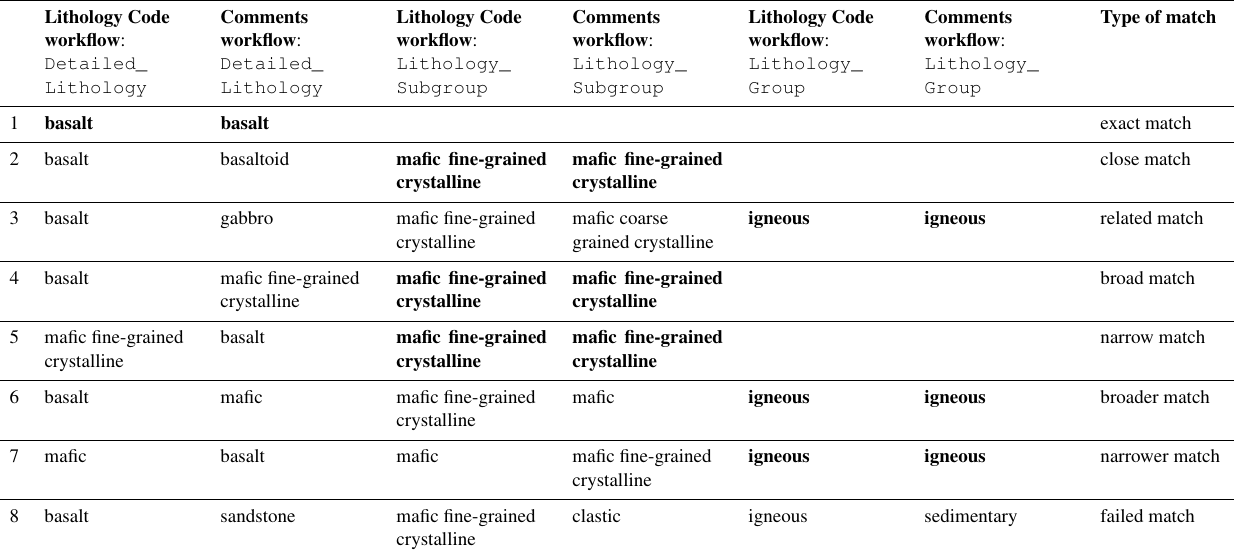
Table 2. Fuzzy string matching terminology used to describe the quality of matches based on the Simple Knowledge Organization System (SKOS) (Miles and Bechhofer, 2009). The values being compared are the Detailed_Lithology level for both the Lithology Code workflow and Comments workflow . The level at which the records are considered to match are in